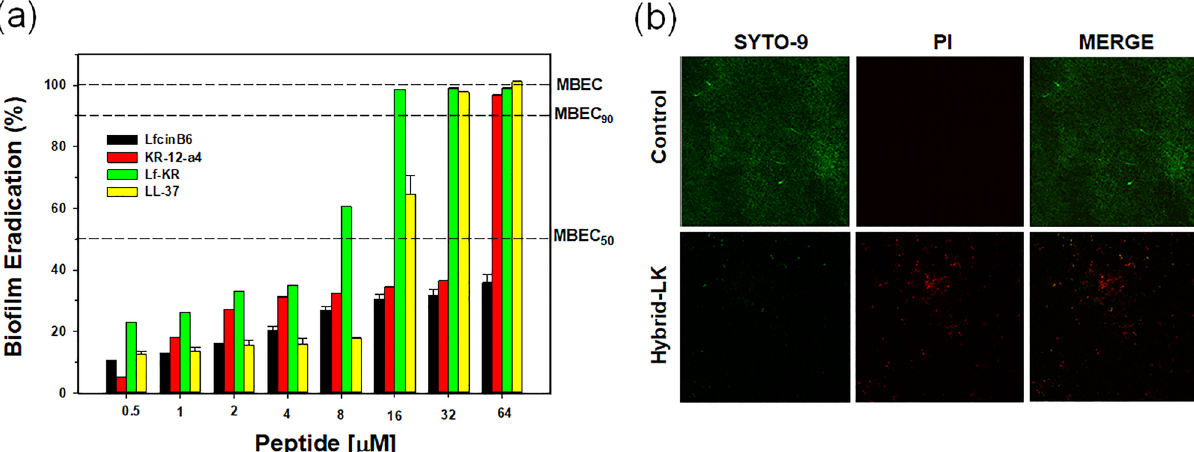
Figure 8. ( a ) Biofilm eradication activity of LfcinB6, KR-12-a5, Lf-KR and LL-37 against multidrug-resistant Pseudomonas aeruginosa (MDRPA). The dotted lines indicate 50% and 90% eradication concentrations. ( b ) Effects of Lf-KR on MDRPA mature biofilms were assessed using confocal laser scanning microscopy (CLSM). MDRPA were incubated alone or with Lf-KR (16 μΜ). Biofilms were visualized with live–dead viability staining (SYTO 9/PI). The viable cells exhibited green fluorescence (SYTO 9), whereas the dead cells exhibited red fluorescence